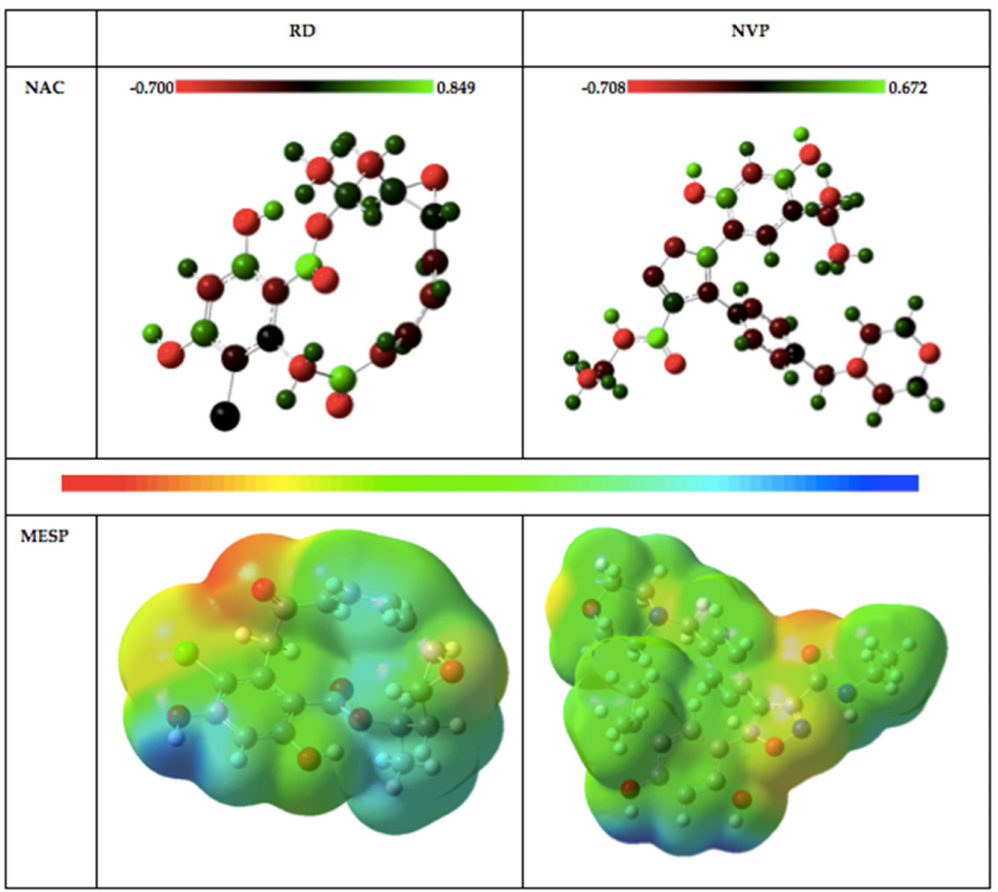
Figure 5. Natural atomic charge (NAC) distribution and molecular electrostatic potential (MESP) plots of the inhibitors at SMD / B3LYP / 6-311G(d, p) DFT